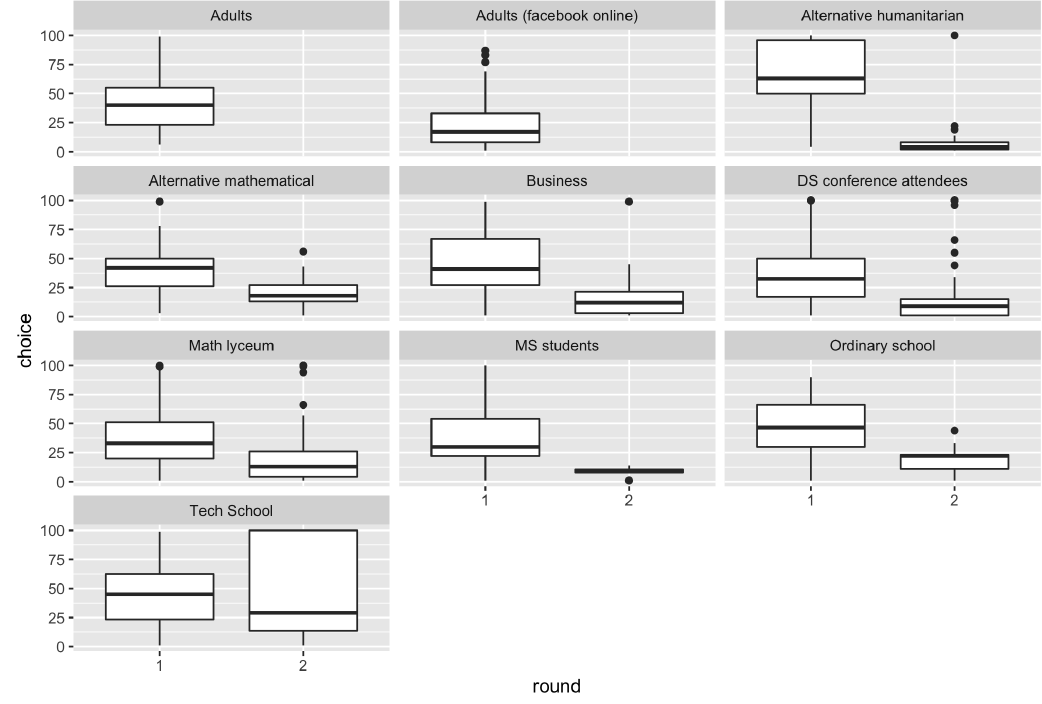
Figure 31: Presentation of paper